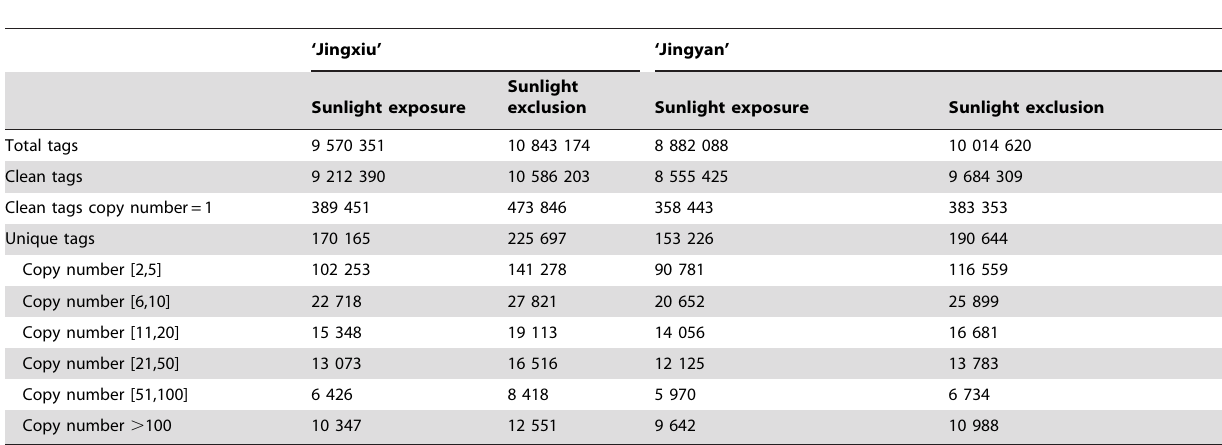
Table 2. Solexa tags in ‘Jingxiu’ and ‘Jingyan’ grape skins under conditions of sunlight exposure and sunlight exclusion.